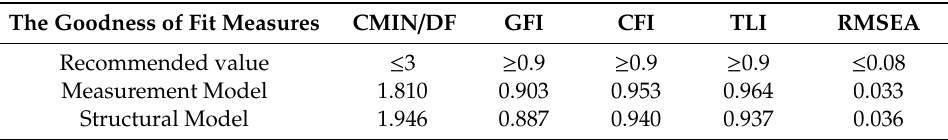
Table 3. Results of measurement and structural model analysis.